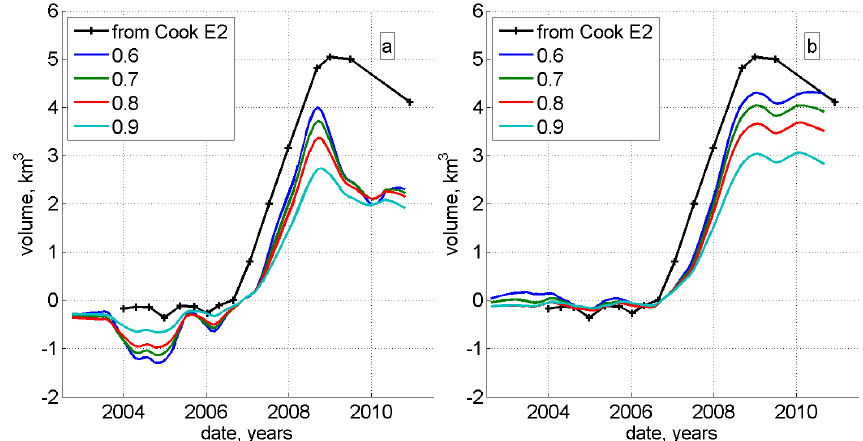
Fig. 8. Chronology of the drainage of Lake Cook E2 and the subsequent storage/release of water in downstream lakes. (a) uncorrected volume of water downstream of Lake Cook E2 from elevation change at lake points. (b) Same volume but corrected for the regional elevation change measured at non-lake points (see Sect. 3.4). In both panels, curve “from Cook E2 ” is the volume of water that drained from Lake Cook E2 , estimated from DEM differencing and ICESat measurements; 0.6–0.9 curves: volume of water stored in active lakes downstream of Lake Cook E2 , These curves are labelled according to the different correlation thresholds used for detecting the lakes (see Sect. 3.4).